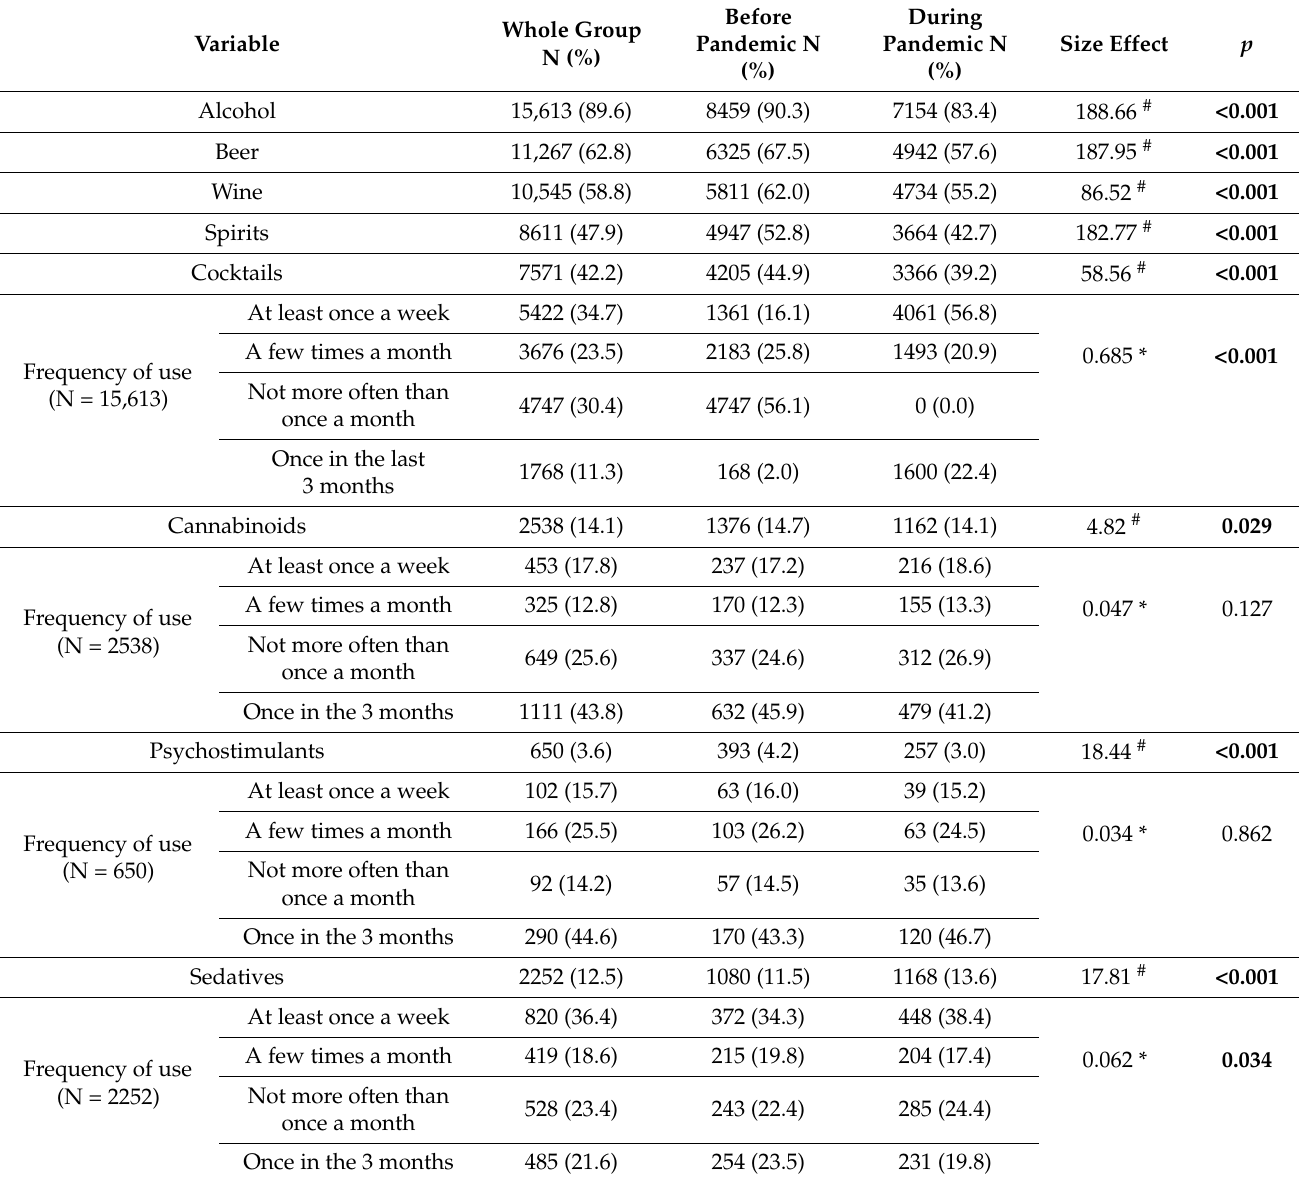
Table 2. Percentage comparison of students using alcohol, psychostimulants, cannabinoids and sedatives in relation to the COVID-19